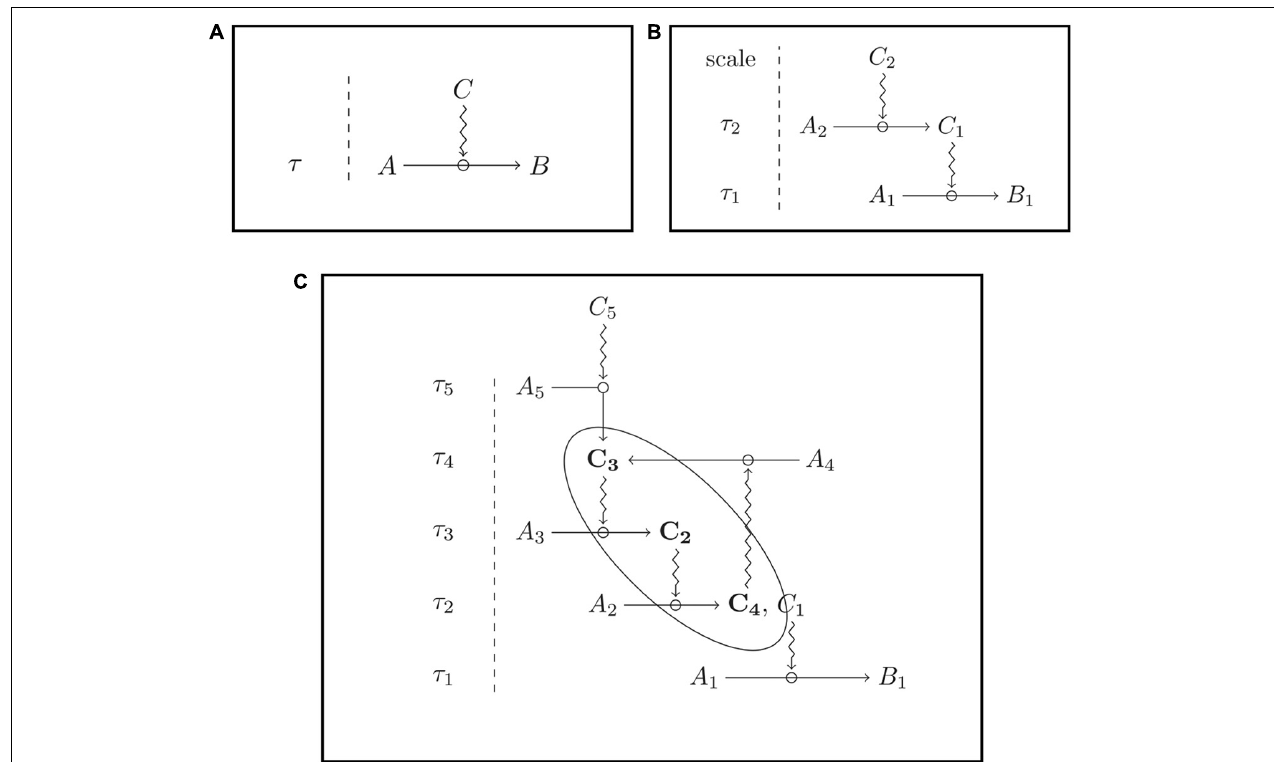
FIGURE 1 | Constraints act upon processes and remain stable at the scale of these processual changes. (A) The constraint C acts over a process A > B; (B) dependence between constraints: the constraint C1 is dependent on the presence of another constraint, C2; (C) closure of constraints: the constraints C3, C2,